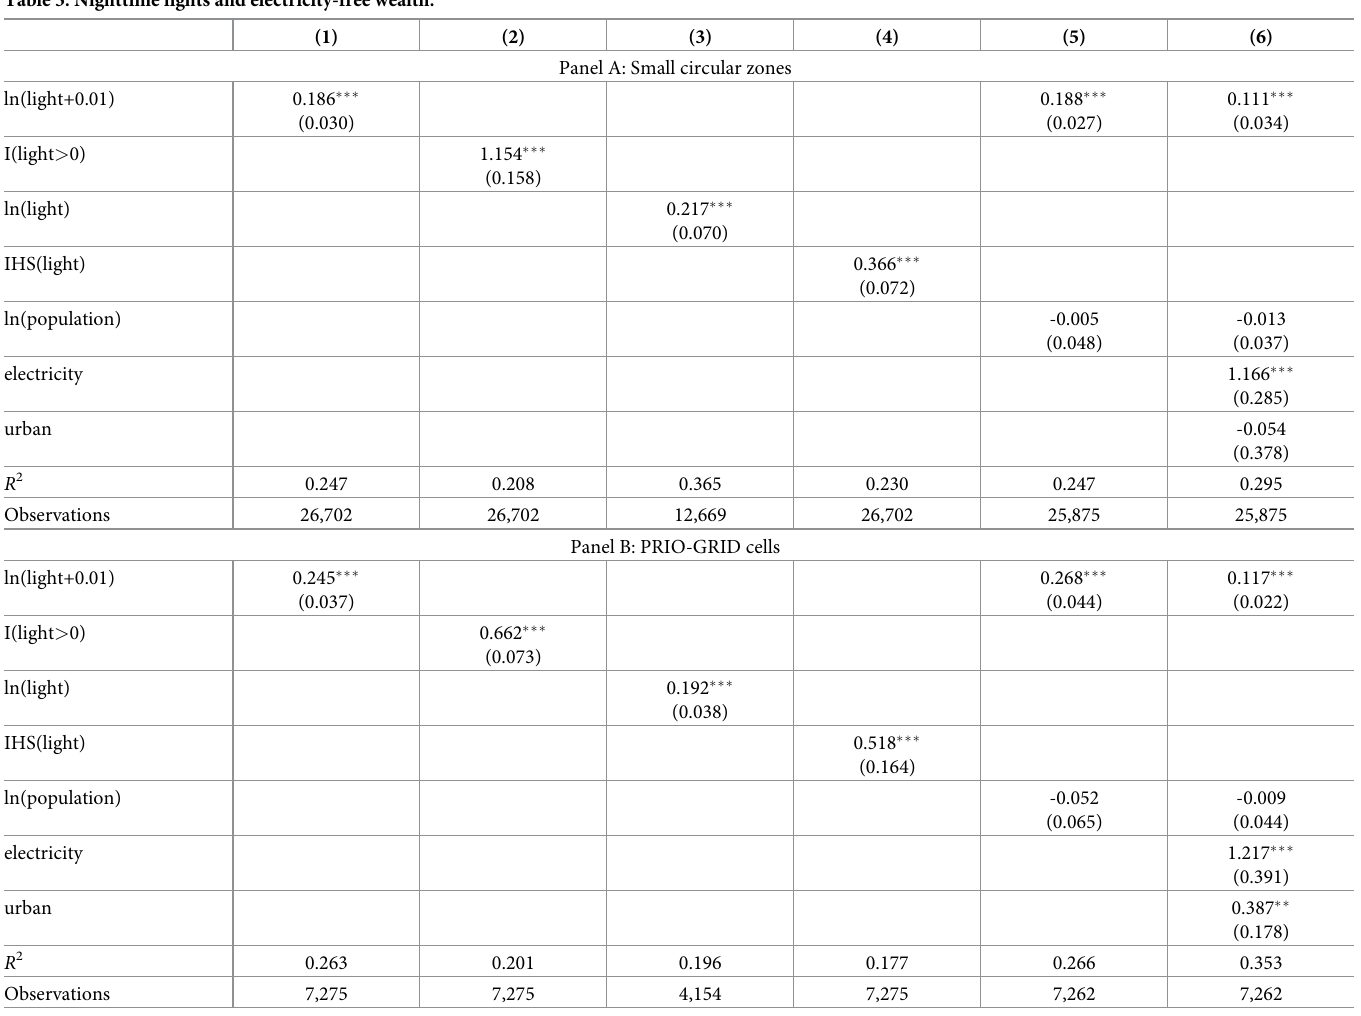
Table 3. Nighttime lights and electricity-free